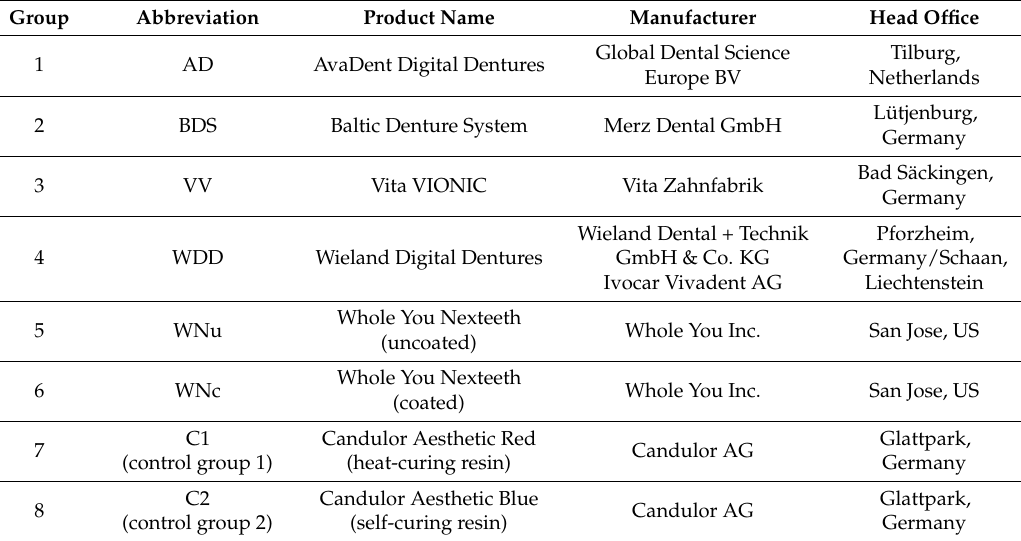
Table 1. Study groups and